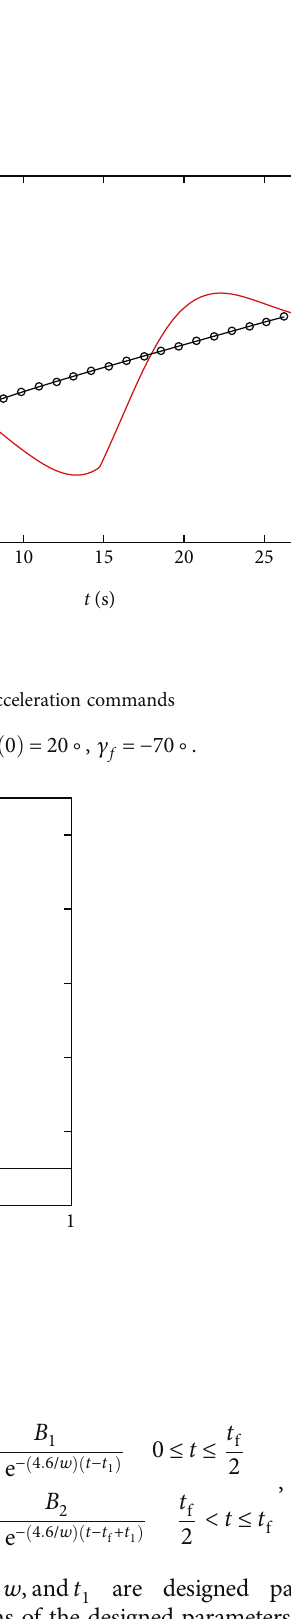
Figure 16: Pro fi le of the weighting function S